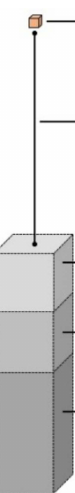
Figure 1. Source-detector geometry used in GEANT4 simulations depicting the varying detector volumes with constant source